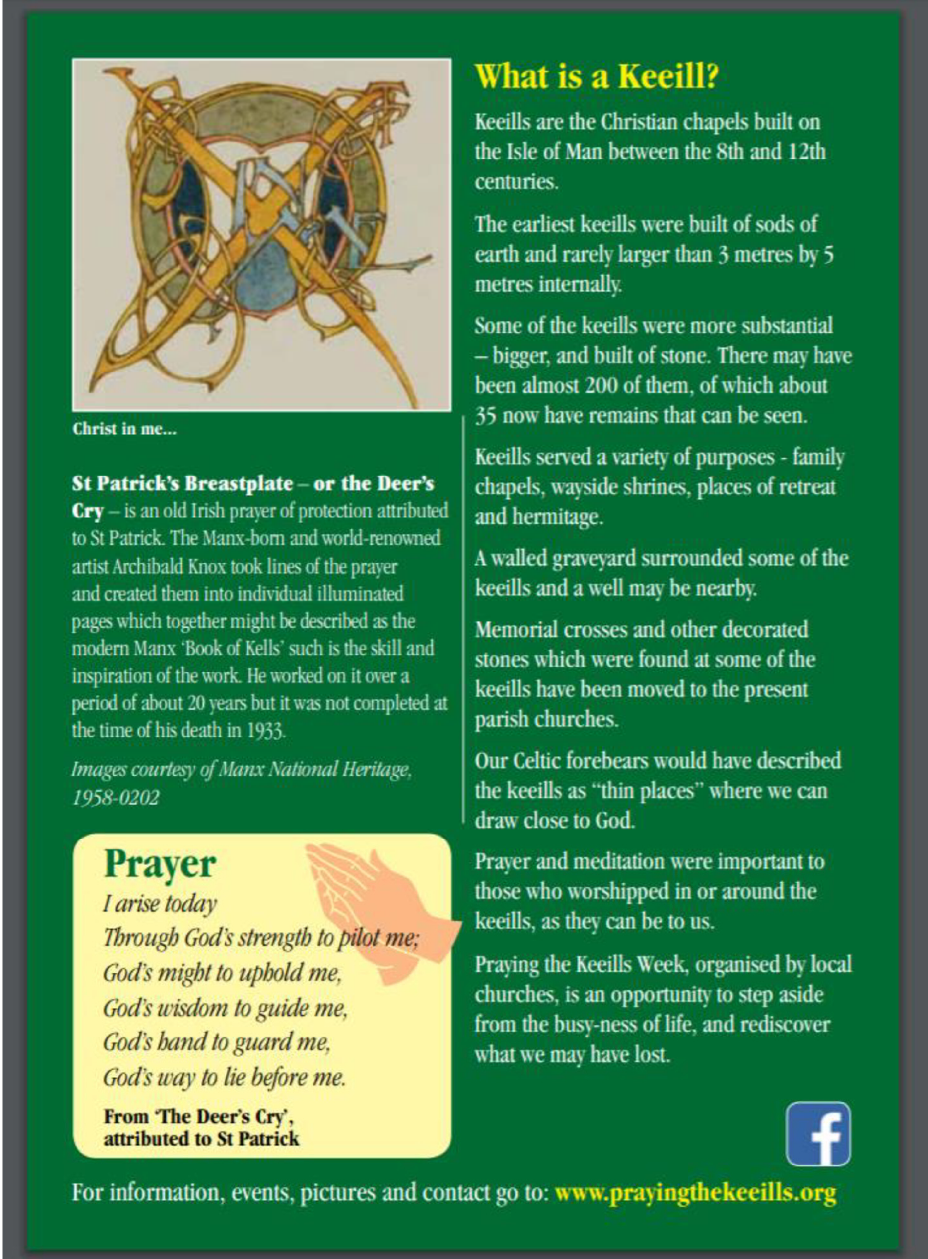
Figure 2. Extract from Praying the Keeills Programme 2019, including an excerpt from ‘The Deer’s Cry’ and art work by Archibald Knox (reproduced by kind permission of PTK).